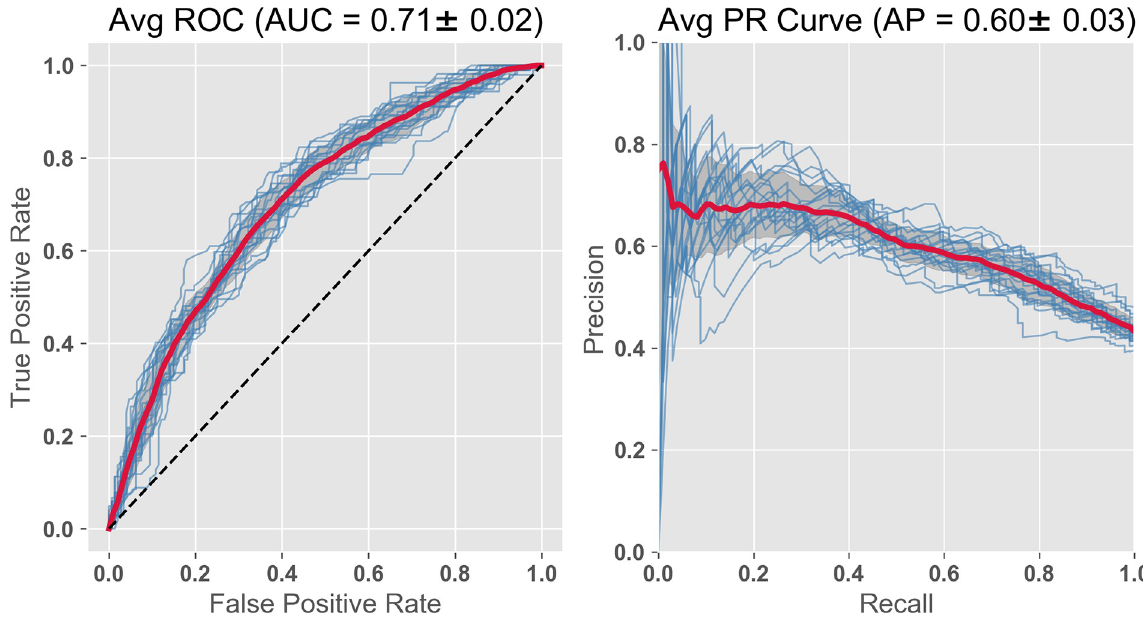
Fig 4. RF Classifier with subset of plasma BMs, compressed cognitive scores, and demographics. The features include the 2 compressed ADNI cognitive variables, 14 plasma analytes chosen from the literature (including 9 Apolipoproteins (Ai, Aii, Aiv, B, Ci, Ciii, D, E, H) plus leptin, insulin, CRP, vitronectin). Demographics included, systolic BP, BMI, age, gender. The importance is displayed as the GINI coefficient below in Table 1. AUC = 0.71; PR curve = 0.60.